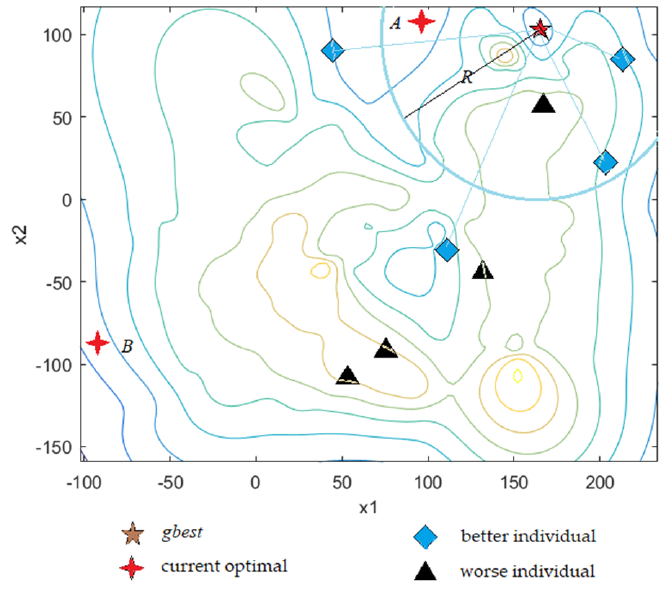
Figure 6. Different situations for triggering the update operation.